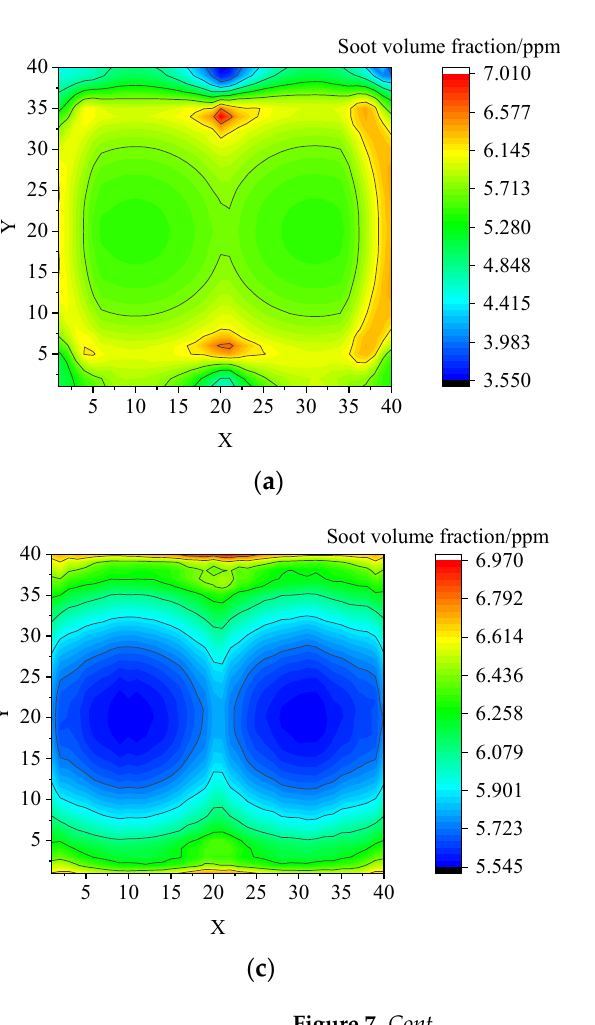
Figure 6. Reconstruction results of the two algorithms with different numbers of cameras: temperature-reconstruction results of the regularization algorithm at four cameras ( a ), six cameras ( c ) and twelve cameras ( e ) and the results of the LSQR algorithm at four cameras ( b ), six cameras ( d ) and twelve cameras ( f ).